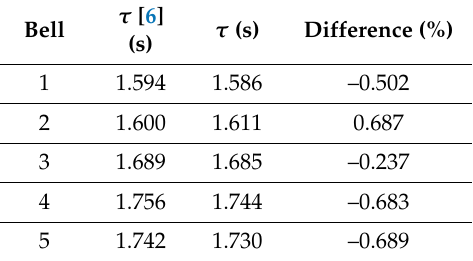
Table 6. Comparison with small oscillation period measured in 1993 [6].